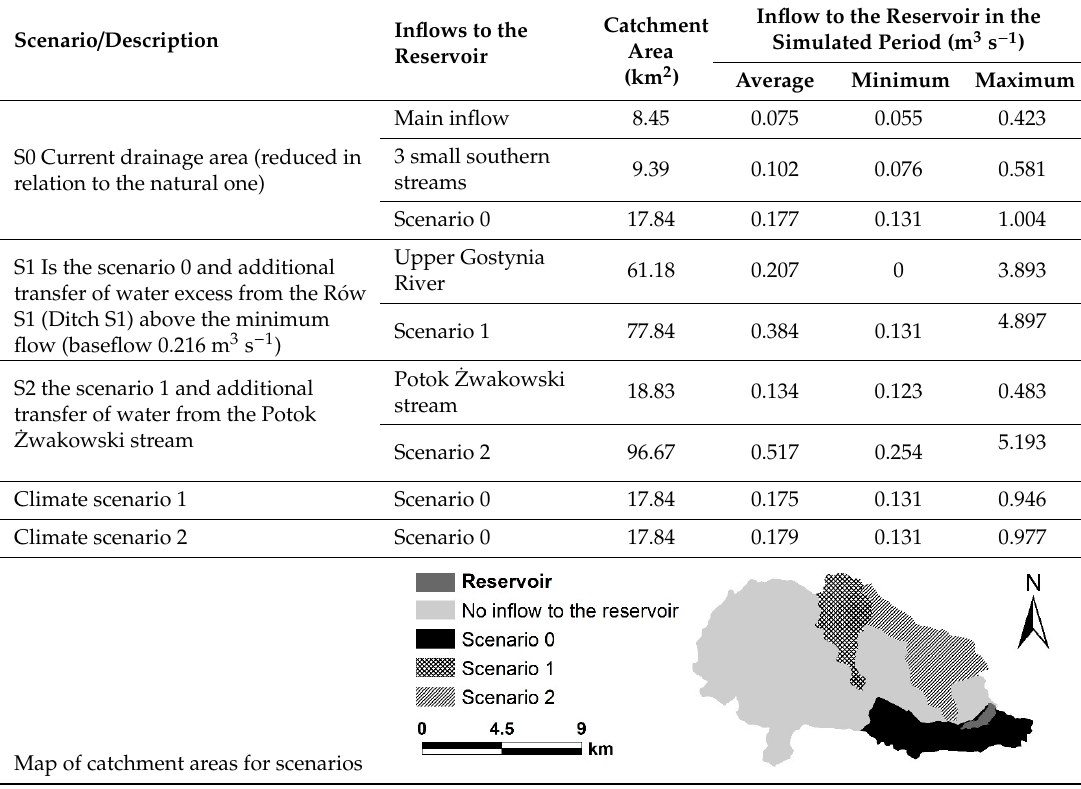
Table 4. Summary of scenarios used in the AEM3D model.